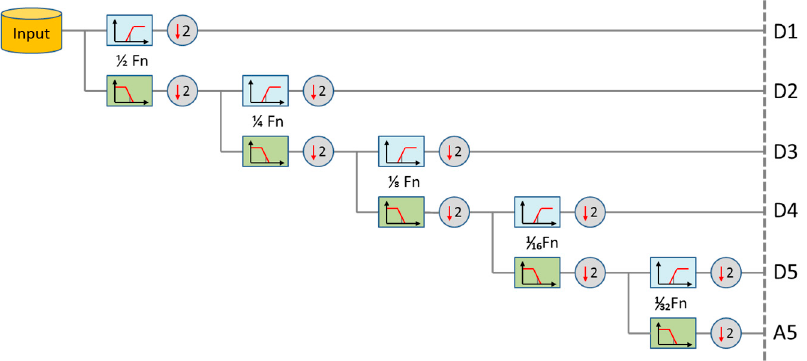
Figure 7. The 5-level decomposition using Daubechies discrete wavelet transform (DWT).